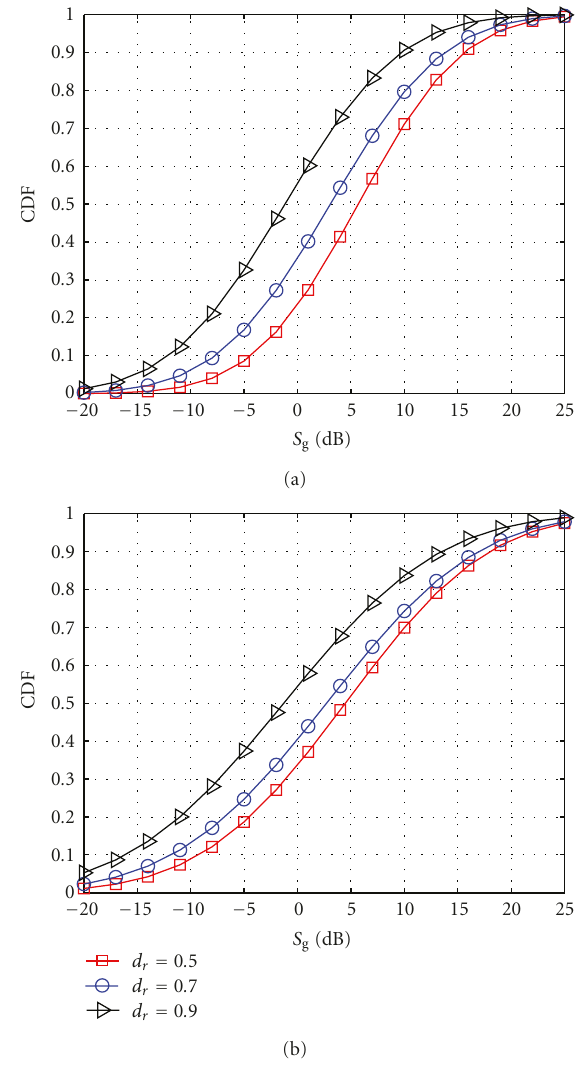
Figure 2: The CDF of power gain from relaying in one-dimensional case. The value of d r stands for the ratio of the lengths of the relaying link to the direct link. Case (a): Shadow fading only. Case (b): Shadow fading and fast